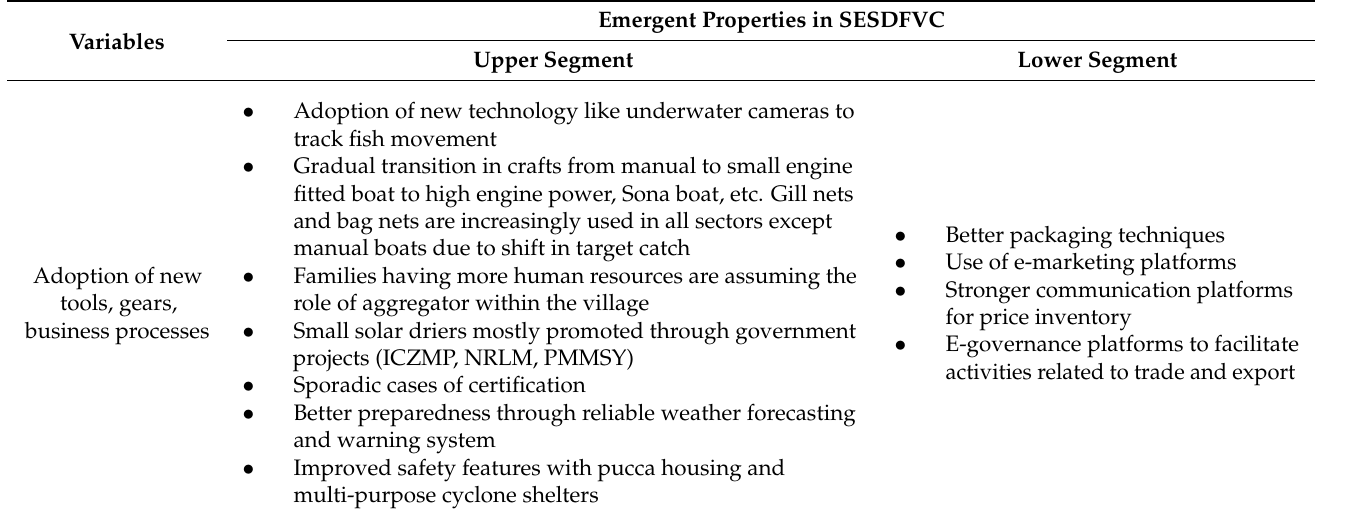
Table 8. Technology and skill dimensions of emergence in